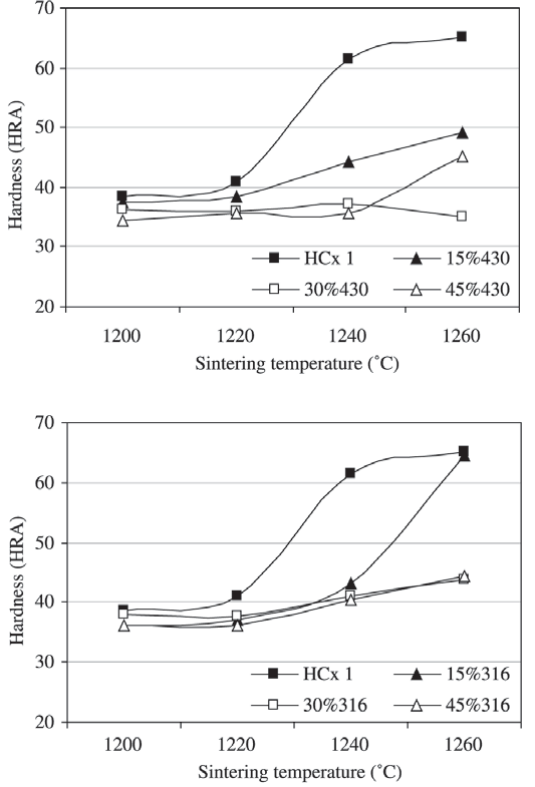
Figure 4. Hardness (HRA) of diluted materials vs. sintering tem- perature.